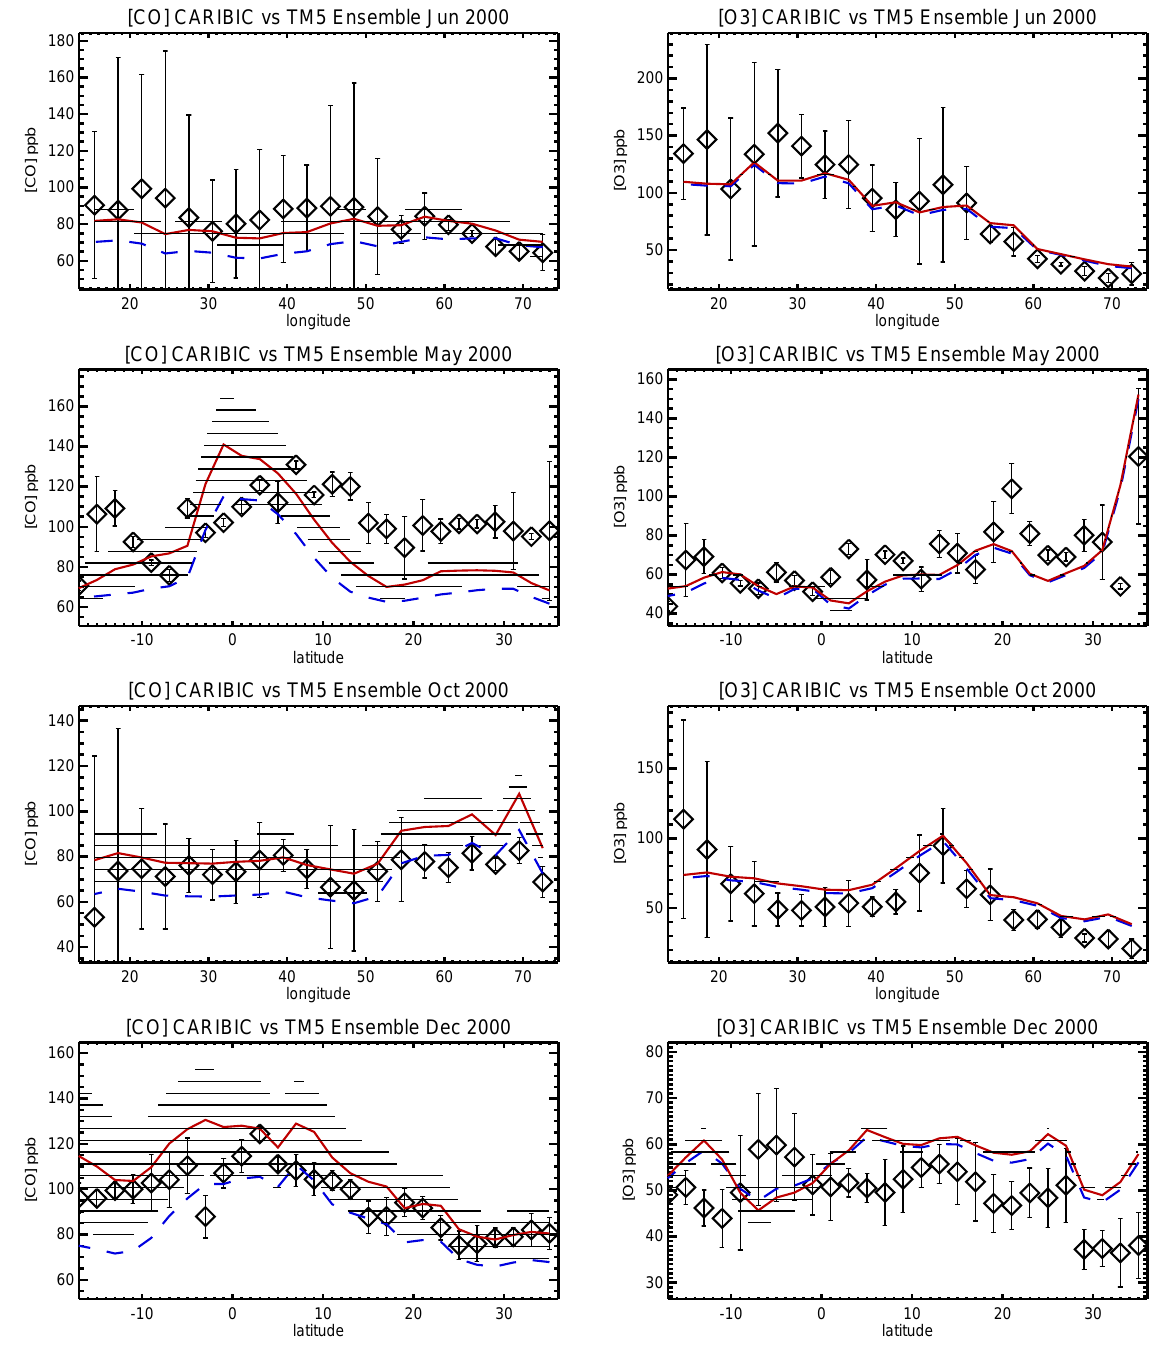
Fig. 10. Comparisons of CARIBIC in-situ flight data ( ♦ ) with the TM5 model ensemble (red line), the NOBVOC simulation (dashed blue line) and 1- σ spread in the model ensemble (hashed area). The months shown are May, June, October and December for the year